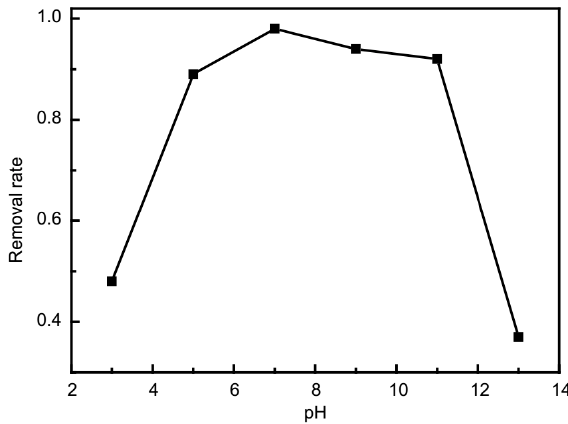
Figure 9. The influence of pH on MB adsorption over Fe 3 O 4 @ 1 adsorbent.